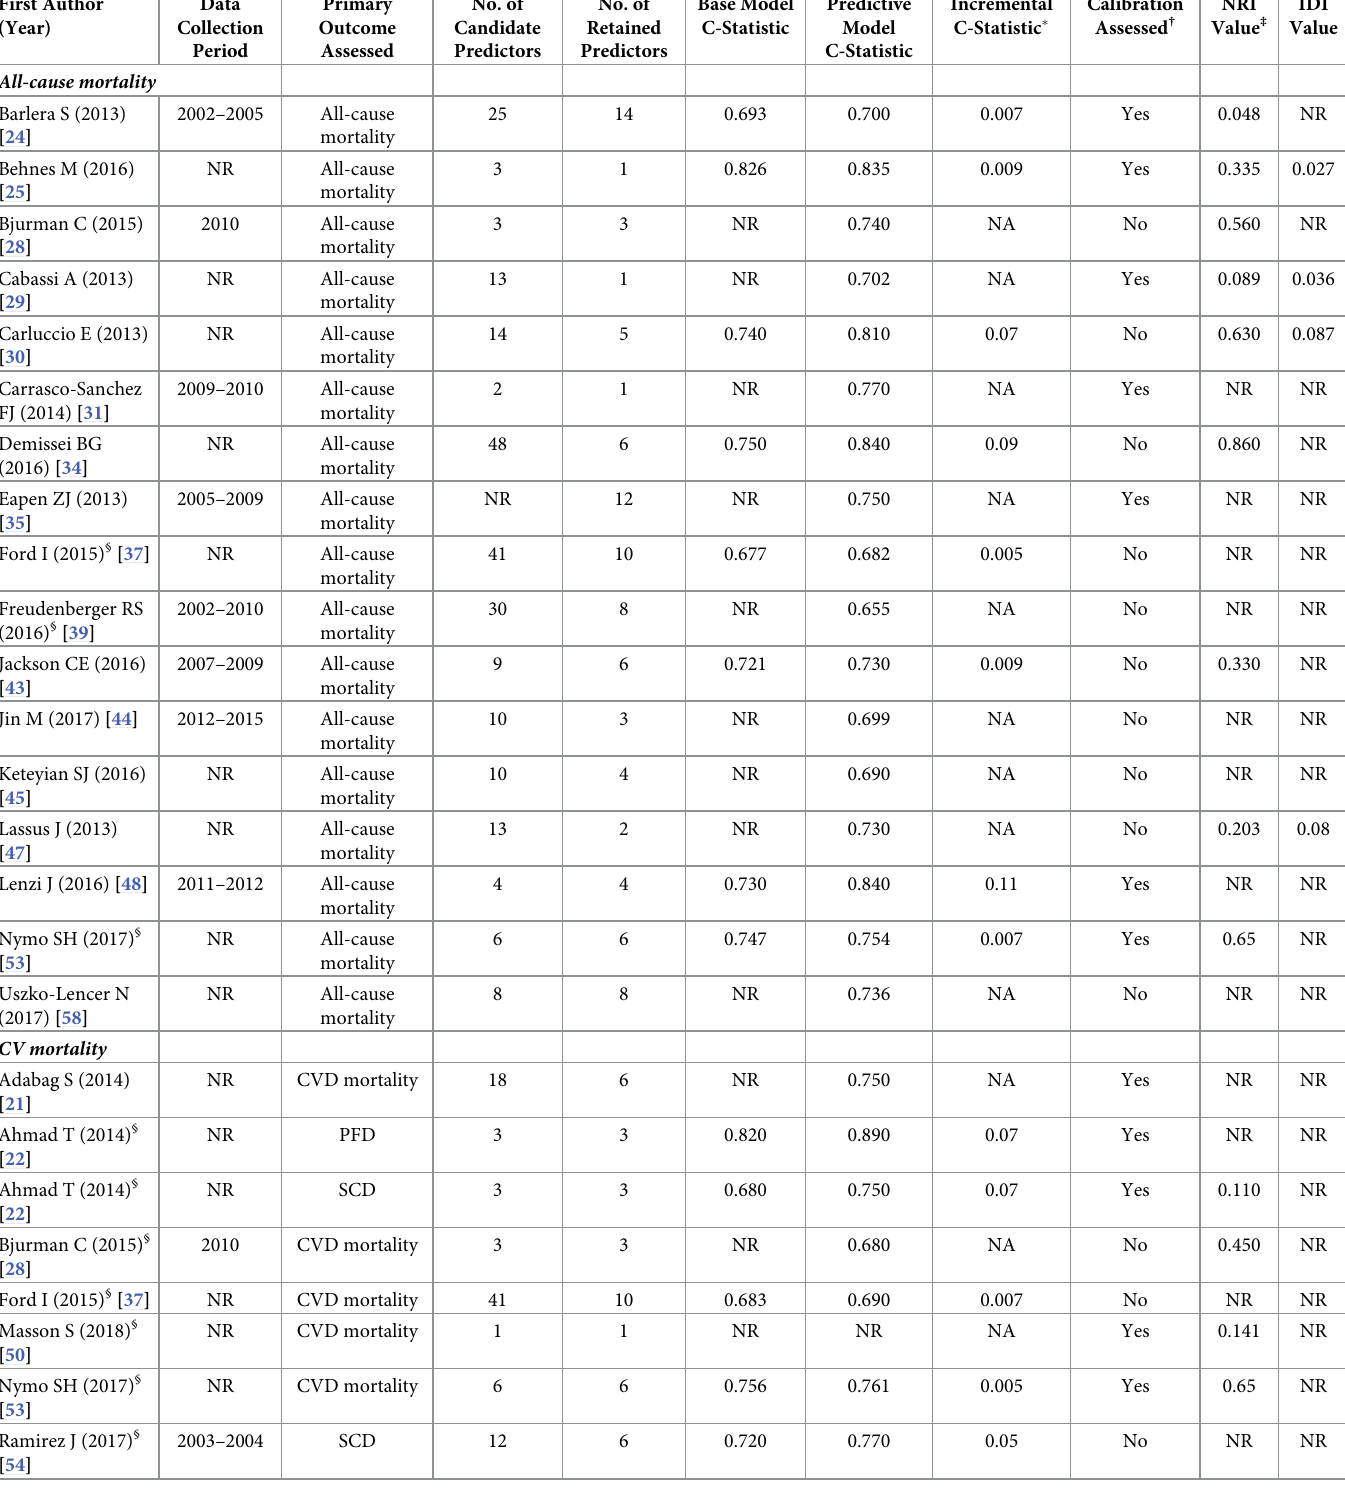
Table 3. Predictive performance of 55 model outcomes from the 40 retrieved publications on risk prediction in